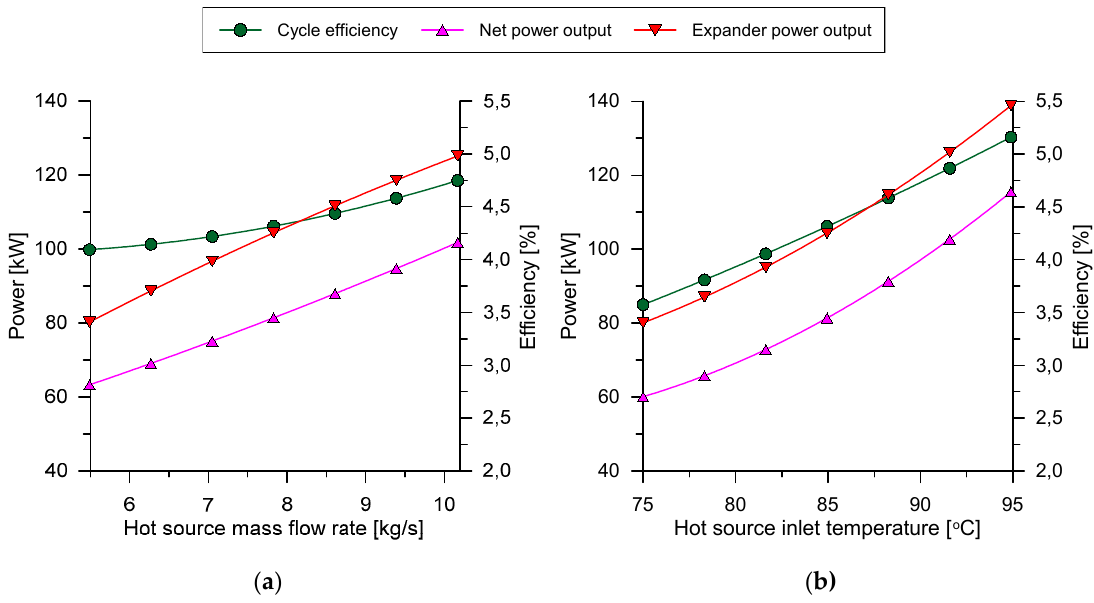
Figure 11. Results of the system and expander performance in on and off-design conditions varying: ( a ) the hot source mass flow rate and ( b ) the hot source inlet temperature.